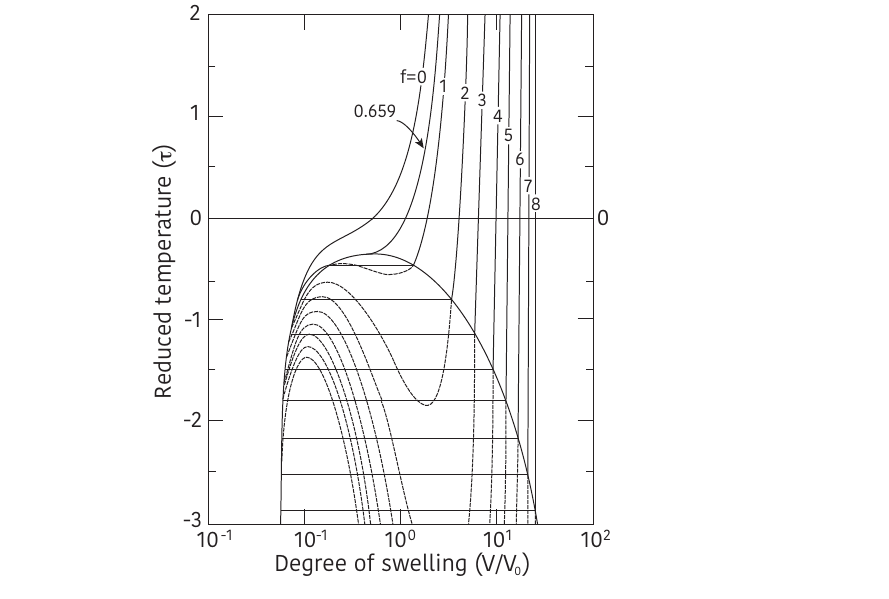
Figure 2. The theoretical swelling curve of gel calculated by Equation (8). The swelling curves are calculated for various values of ionic component on the active chain of the gel, f . Reproduced with permission from Ref. [8]. © 1986, The Physical Society of